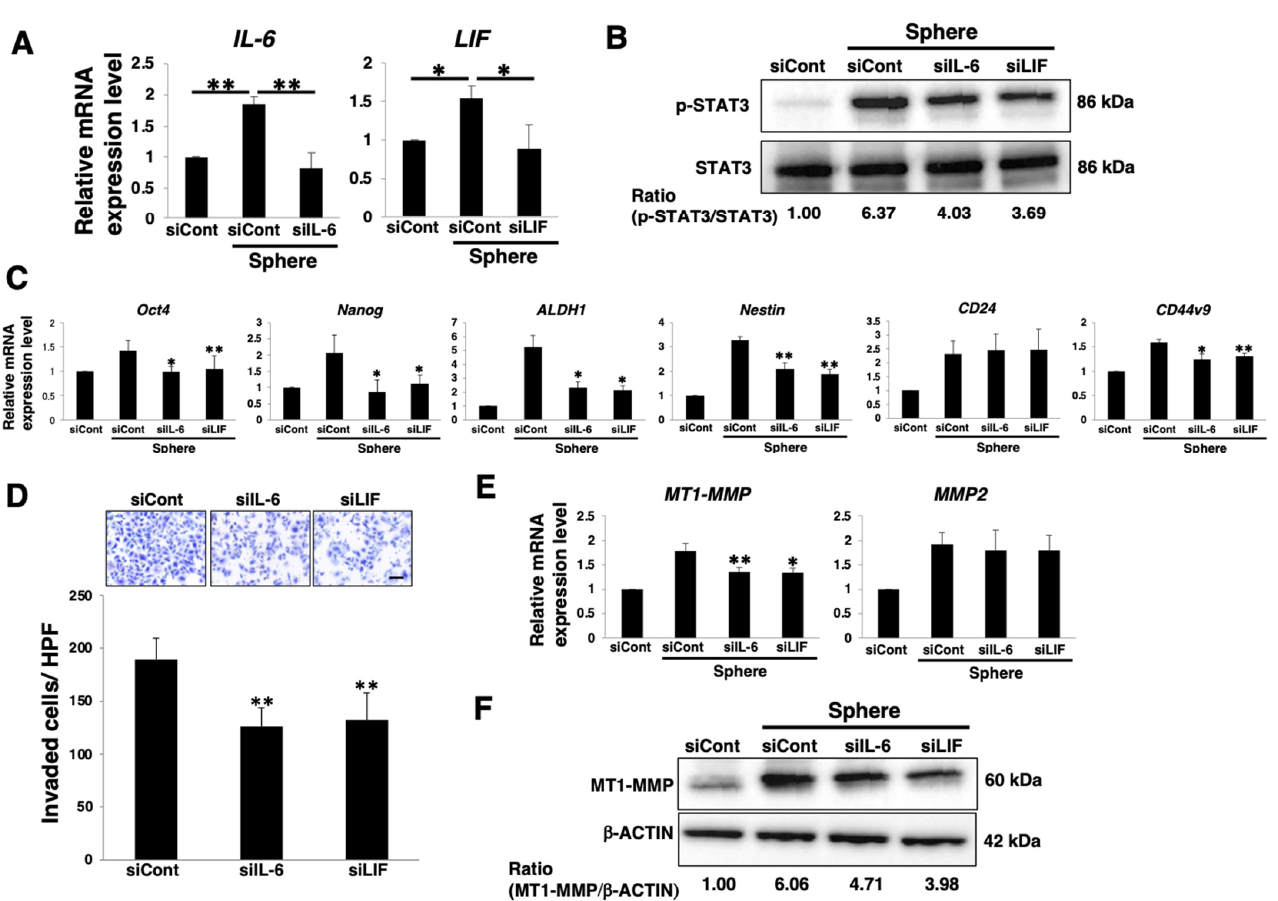
Figure 4. Autocrine/paracrine IL-6 or LIF/gp130/STAT3 pathways involved in stemness and inva- sion of PDAC sphere cells. PANC-1 cells were cultured for 7 days in 2D (adherent) or 3D (sphere) conditions after siRNA transfection. The cells were harvested and then used in the following exper- iments. ( A ) Real-time qPCR analysis of IL-6 or LIF . Results are normalized to values obtained for adherent cells (value = 1). Results are presented as means ± SD from three independent experiments. ( B ) Western blot analysis of p-STAT3 and STAT3. Relative band intensity is presented. ( C ) Real-time qPCR analysis of stemness markers. Results are normalized to values obtained for adherent cells (value = 1). Results are presented as means ± SD from three independent experiments (* p < 0.05, ** p < 0.01 vs. siCont transfected sphere cells). ( D ) Matrigel invasion assays were performed in PANC-1 sphere cells. Representative results from measurements of 12 fields are presented (* p < 0.05, ** p < 0.01 vs. siCont transfected sphere cells). Scale bar: 100 µ m. ( E ) Real-time qPCR analysis of MT1-MMP and MMP2 . Results are normalized to values obtained for adherent cells (value = 1). Results are presented as means ± SD from three independent experiments (* p < 0.05, ** p < 0.01 vs. siCont transfected sphere cells). ( F ) Western blot analysis of MT1-MMP and β -ACTIN. Relative band intensity is